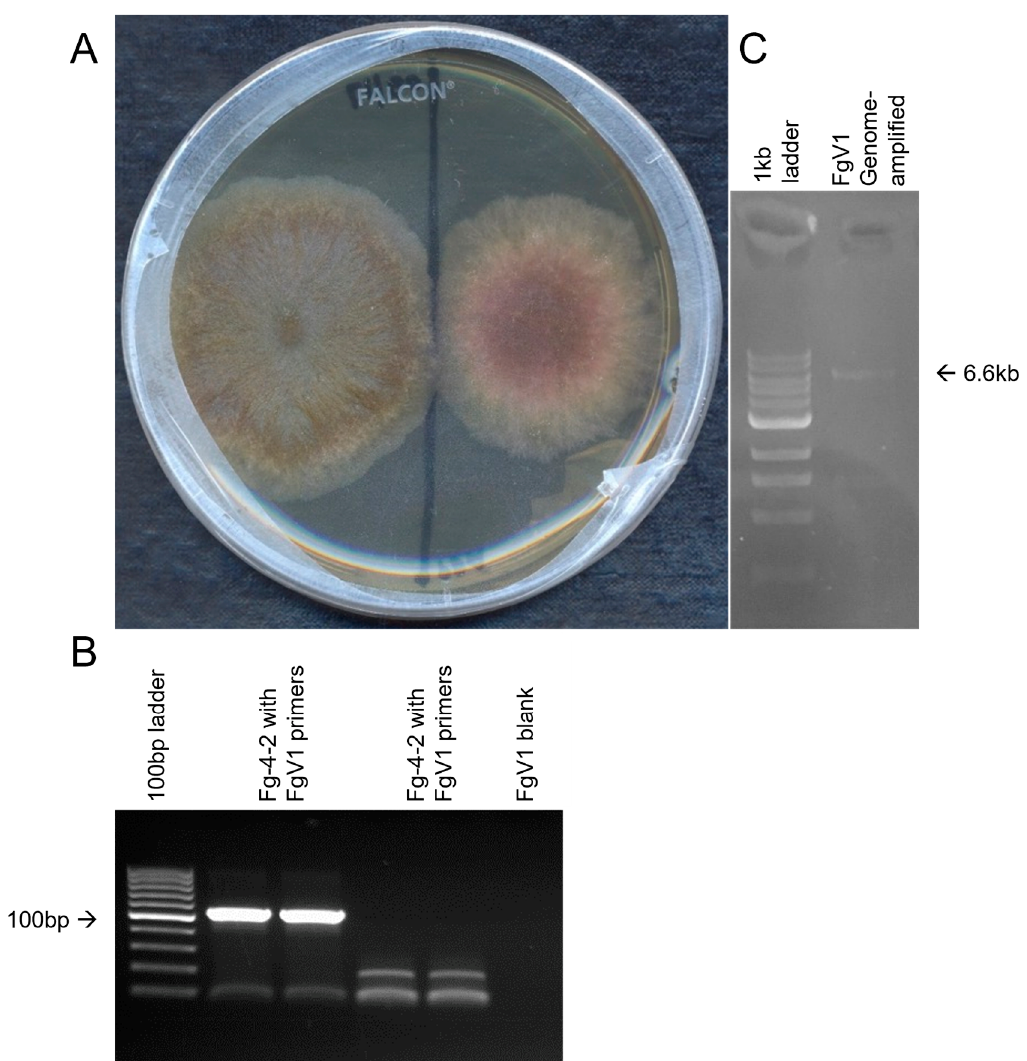
RT-PCR showed that Fg-4-1 is free of FgV1 infection.